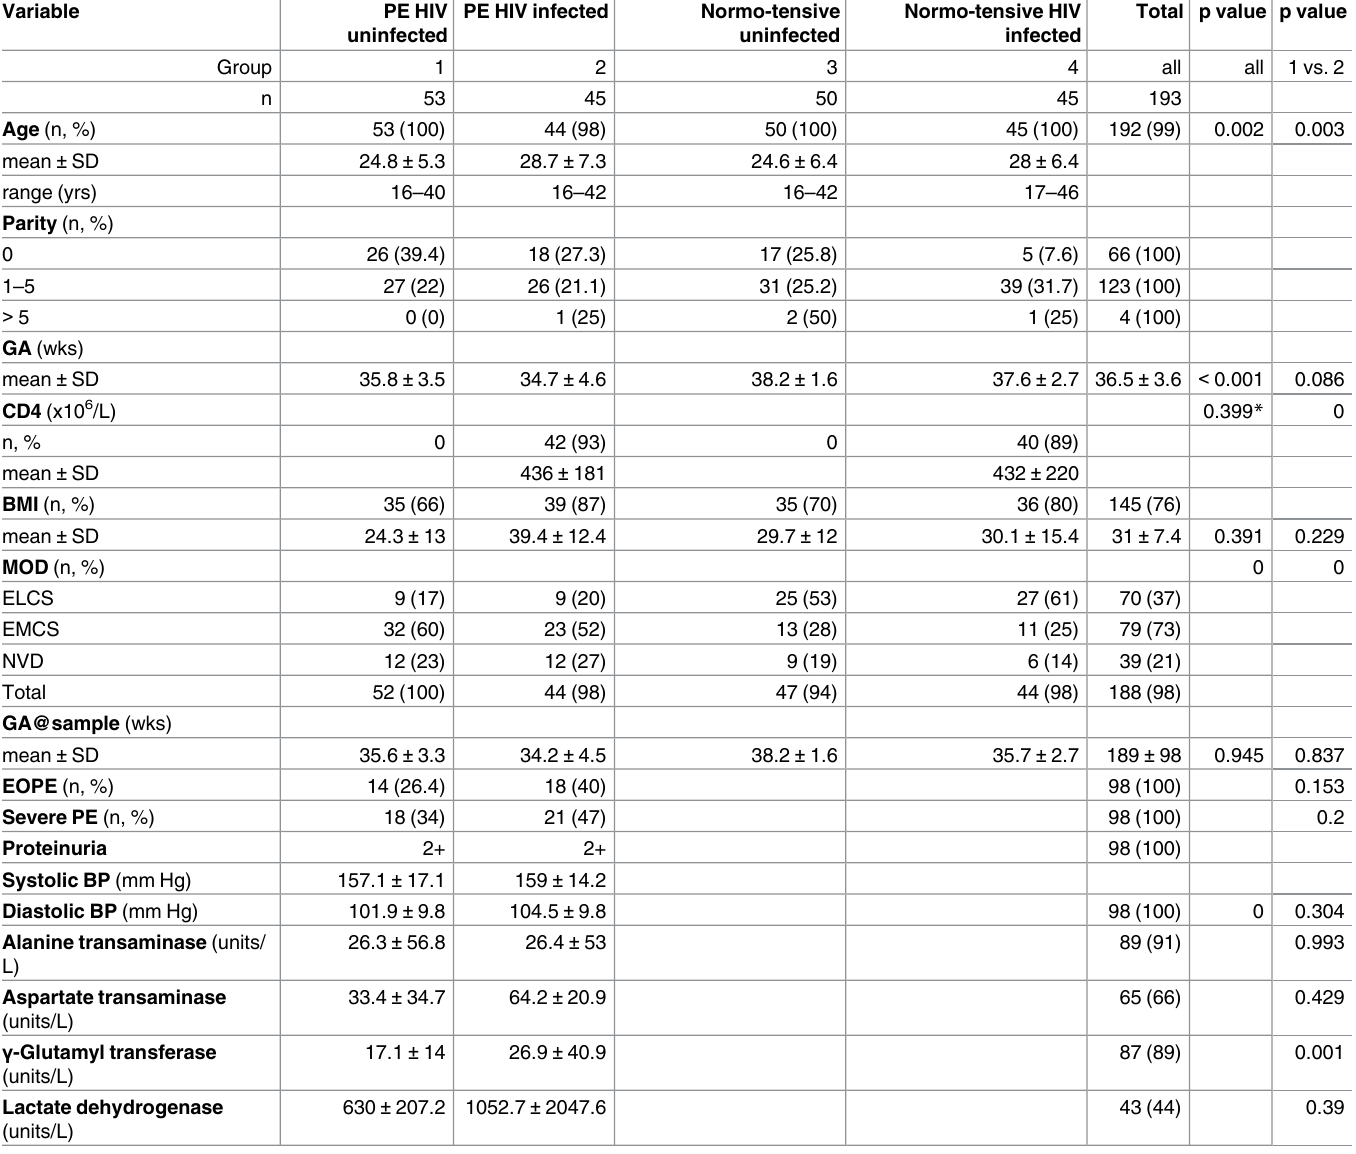
Table 1. Clinical characteristics of